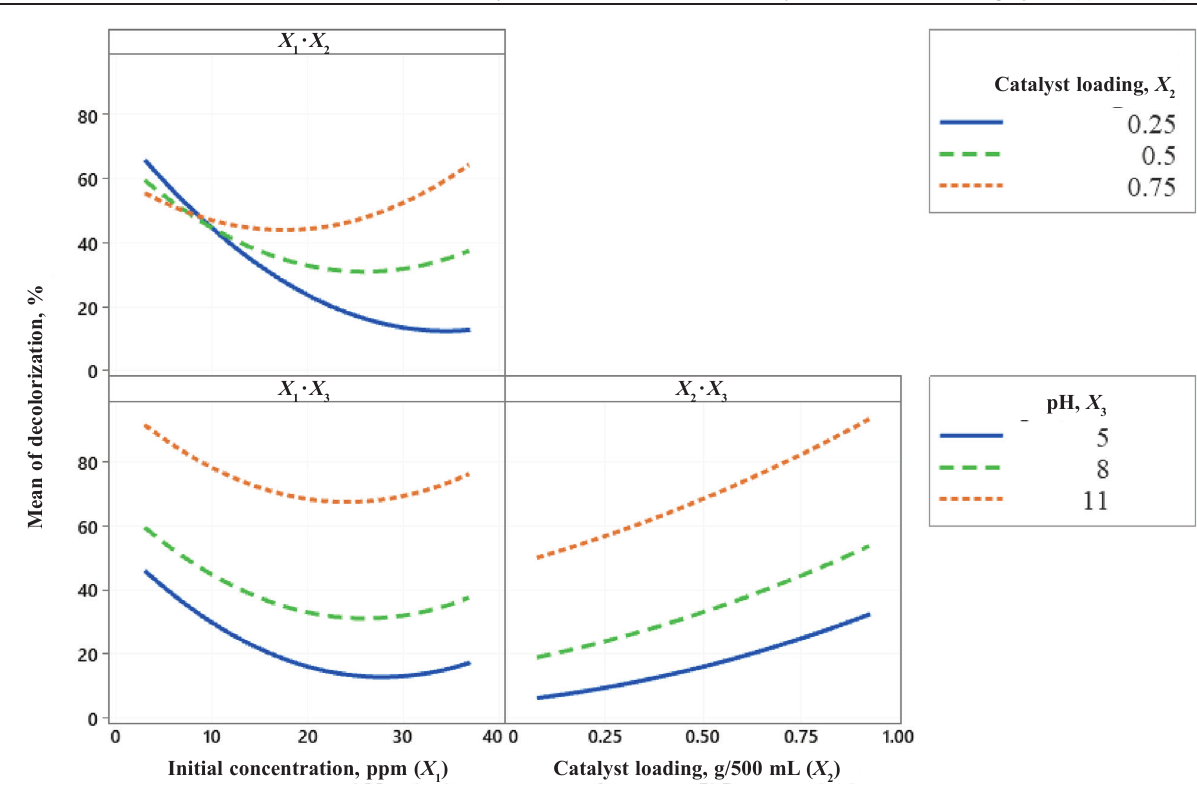
Fig. 5 – Interaction plot for decolorization